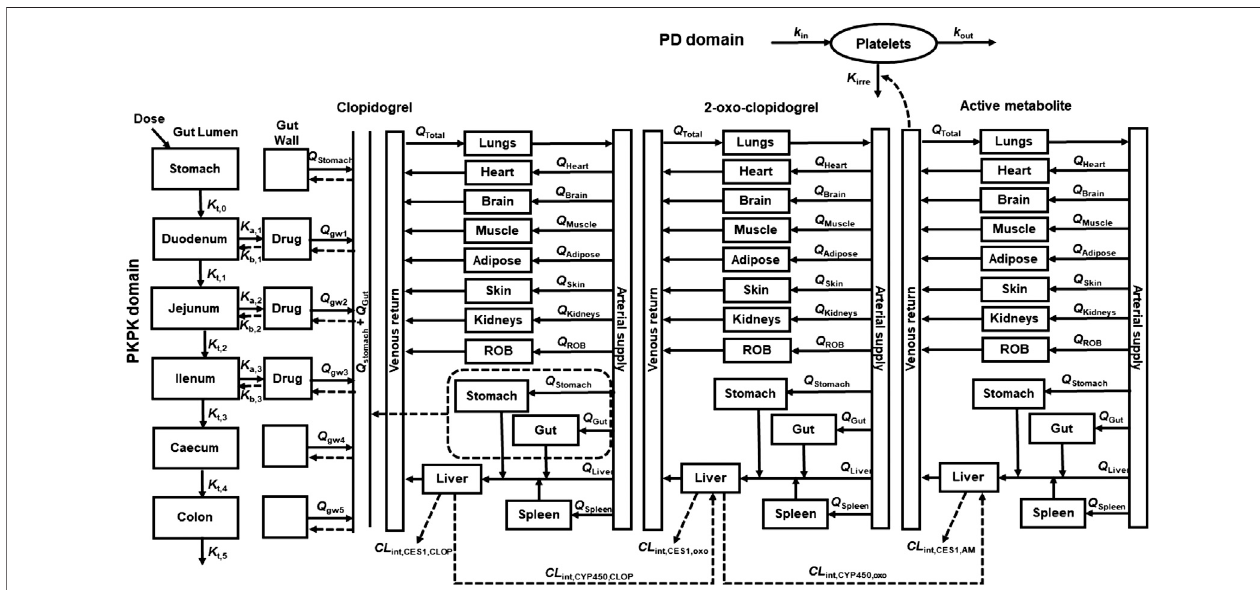
FIGURE1 | Schematic structureof wholePBPK-PD model ofCLOP. Where, gw, ROB, Q and Q total weregut wall compartment,rest ofbodycompartment, blood fl ow rates and cardiac output. K t,i , K a , and K b represent the gastrointestinal transit rate constants, drug absorption rate constant and drug ef respectively. CL int,CYP450 and CL int,CES1 represent the CYP450 and CES1-mediated intrinsic clearances respectively. k irre , k in , and k out were CLOP-AM-mediated irreversible antiplatelet aggregation rate constant, platelet aggregation rate constant and platelet disaggregation rate constant, respectively.